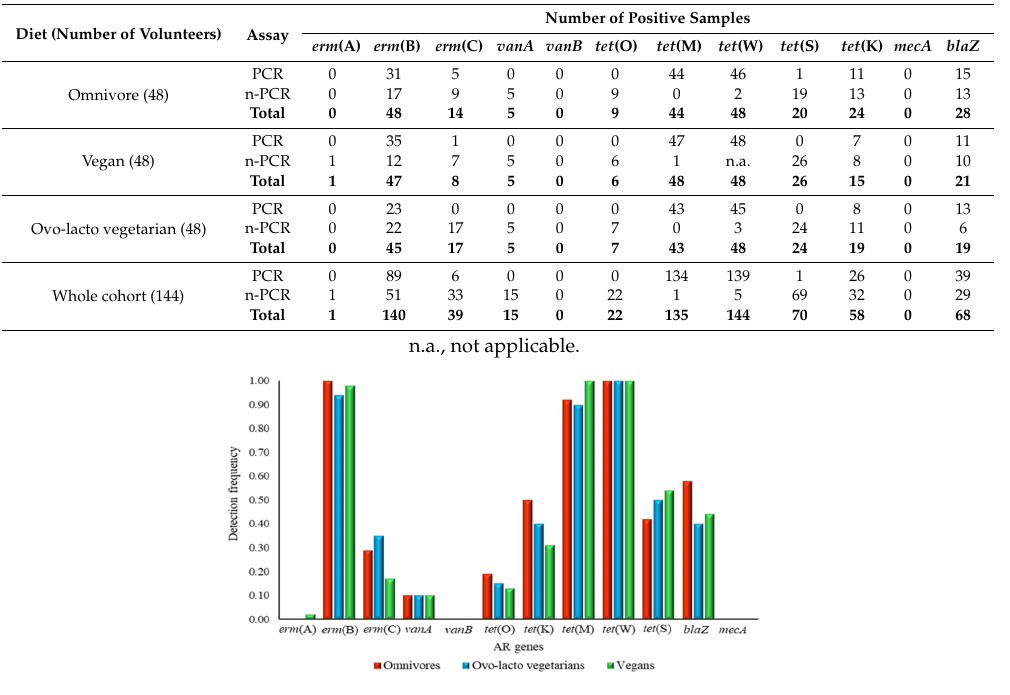
Figure 1. Detection frequency of 12 target antibiotic resistance (AR) genes in the saliva of volunteers following an omnivore, ovo-lacto vegetarian and vegan diet. Table 2. Positive results of PCR and nested PCR (n-PCR) assays targeting the 12 antibiotic resistance (AR) genes of interest, carried out onto saliva samples collected from the three groups of heathy volunteers (each including 48 individuals) following long-term (>1 year) omnivore, ovo-lacto-vegetarian or vegan diet.